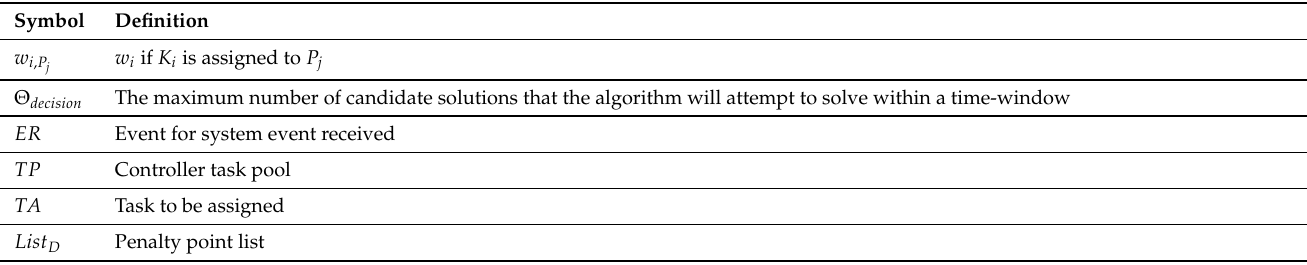
Table 3. Notations in